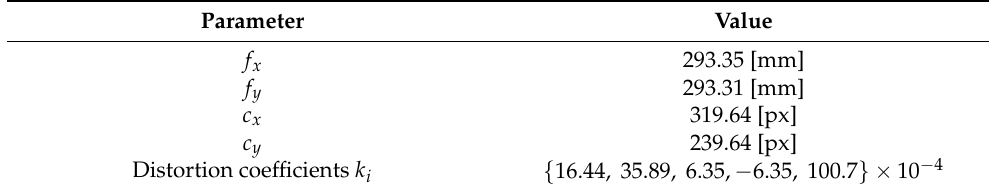
Table 2. Internal camera